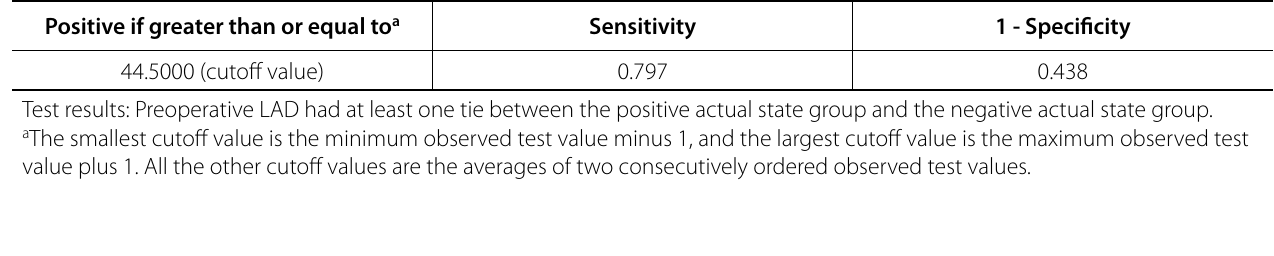
Table 3 . Coordinates of the curve for preoperative LAD values – sinus rhythm on the day of discharge. Coordinates of the curve: